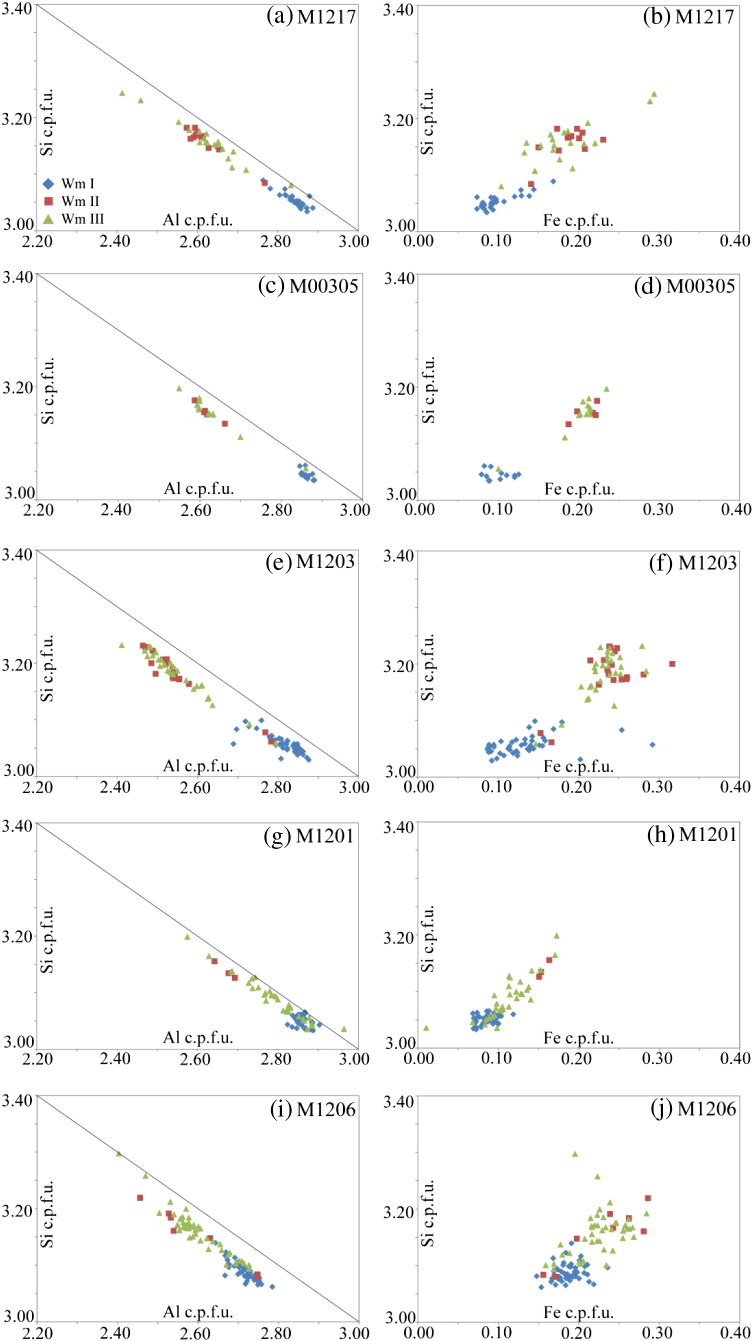
Muscovite compositional data by EMPA of Wm I (blue diamonds), Wm II (red squares), Wm III (green triangles) of (a–b) M1217, (c–d) HM00305, (e–f) M1203, (g–h) M1201 and (i–j) M1206. Note the compositional overlap of different generations in the high-strain samples M1201 and M1206. For legend, see panel a.